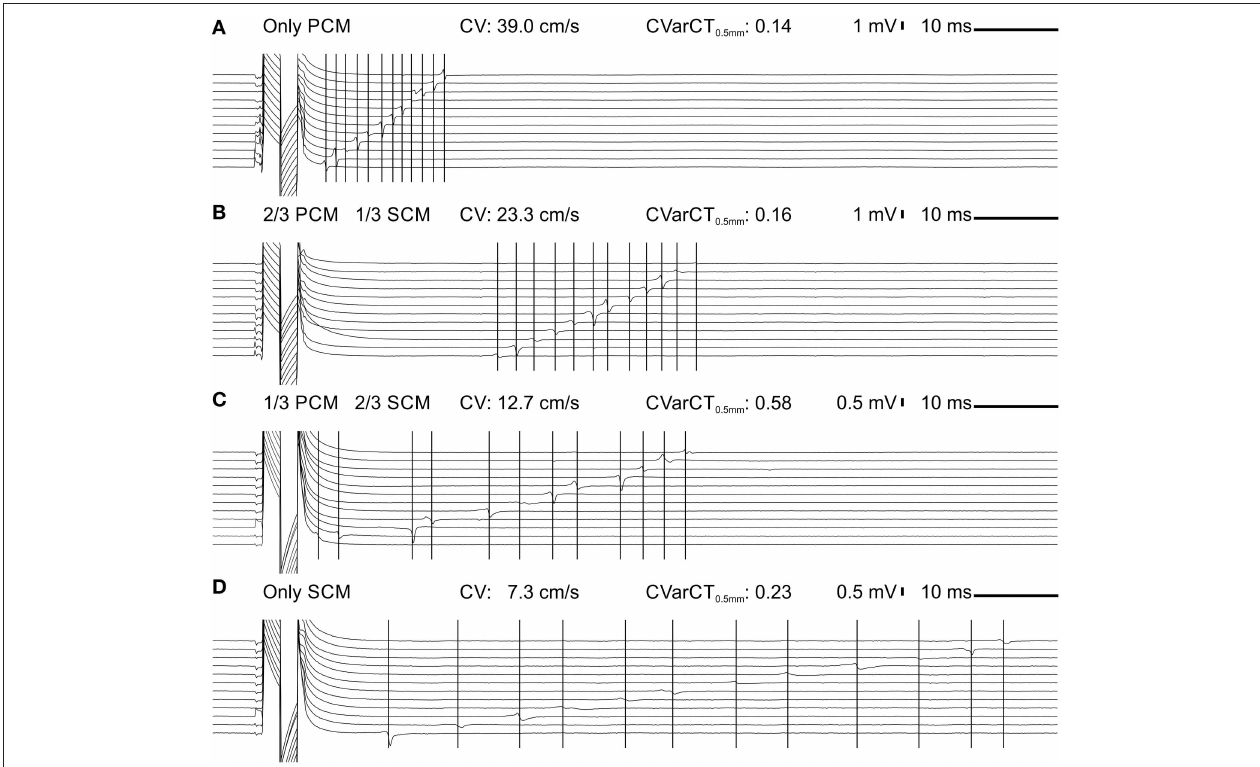
FIGURE 2 | Extracellular signals during impulse propagation in cultured strands grown over a row of 12 electrodes (0.5mm spacing) for preparations with an increasing proportion of SCMs (A: 0; B: 1/3; C: 2/3; D:1). Note the different voltage scale in (C,D) . The large deflection on the left of the traces is the stimulation artifact. The vertical lines denote corresponding activation times during impulse propagation.